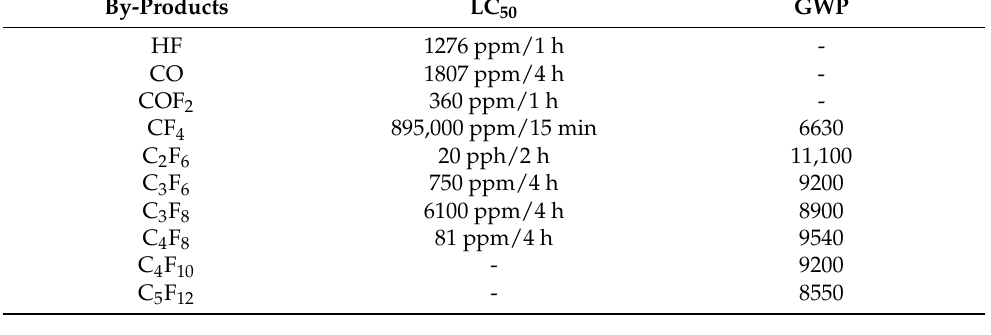
Table 4. LC 50 and GWP data of main decomposition products of C 6 F 12 O [19,20].